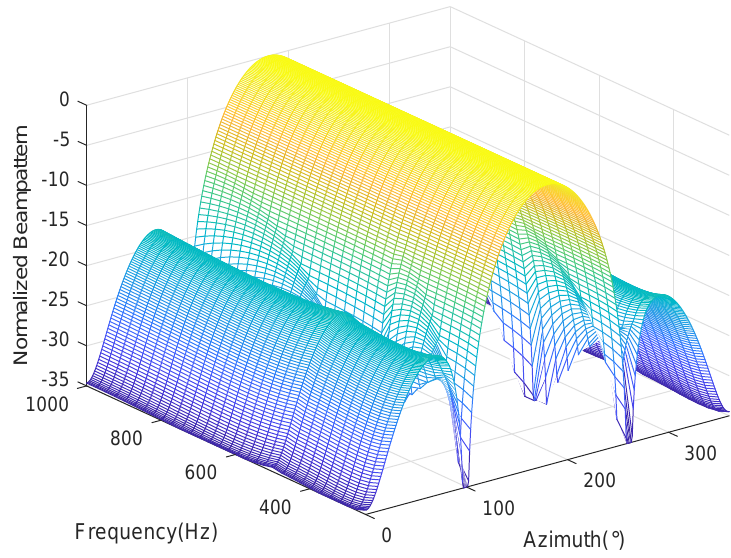
Figure 14. Frequency invariant beampattern over [ 250 Hz ,1000 Hz ] in the azimuth plane, where the elevation angle is fixed to 90 ◦ .